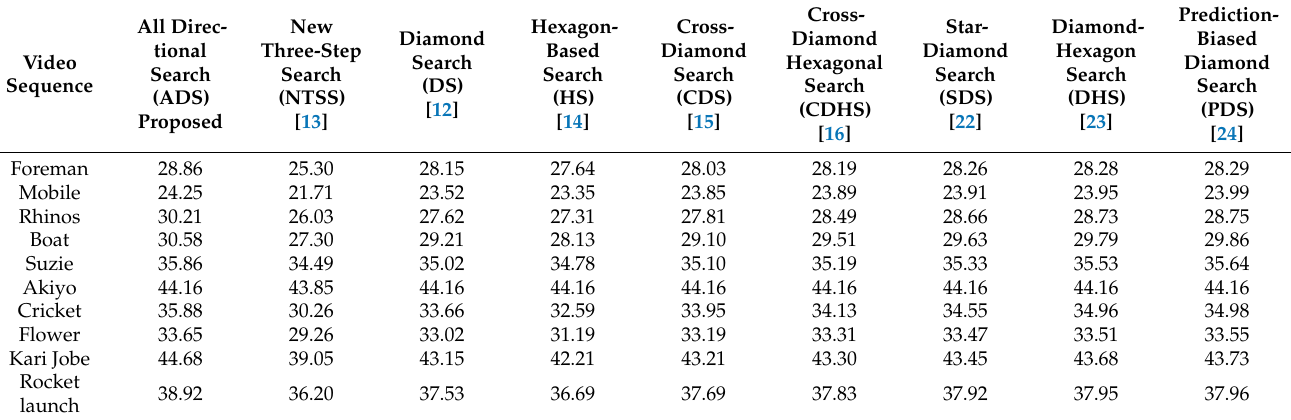
Table 2. The degree of motion prediction quality of every algorithm with respect to the full search